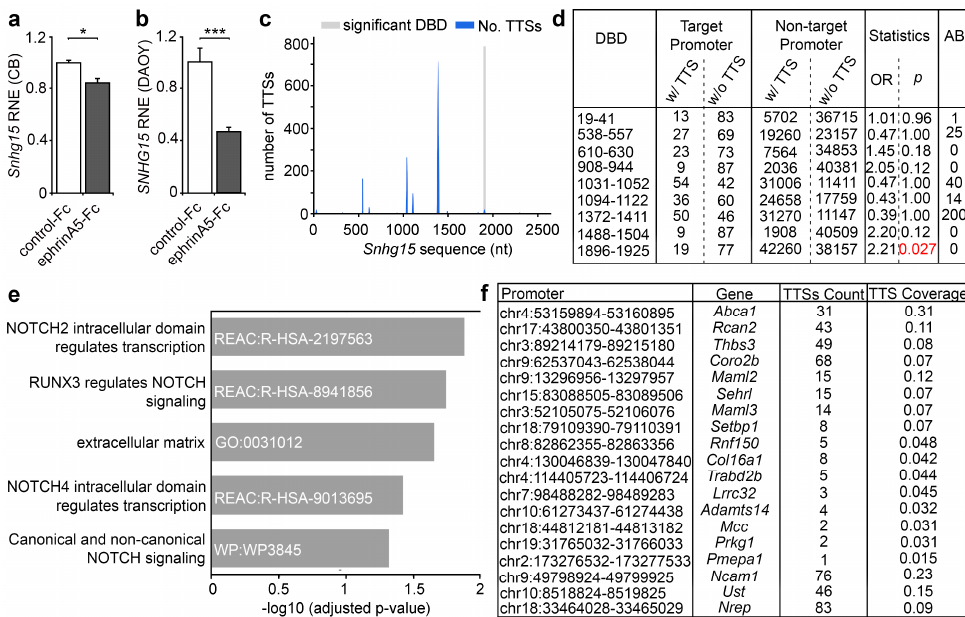
Figure 4. Analysis of Snhg15 expression and potential triplex target DNA sites (TTS) of Snhg15 in genes found differentially expressed upon ephrinA5-Fc stimulation. ( a ) Relative normalized expression (RNE) of Snhg15 in CB cells after ephrinA5-Fc stimulation compared to control-Fc treated CB cells. Expression data and adjusted p -value obtained from RNA sequencing of nuclear enriched RNA of CB cells. Sequencing was performed as n = 3 biological replicates per condition. ( b ) Quan- titative real time PCR analysis of expression of SNHG15 in DAOY cells treated with control-Fc or ephrinA5-Fc. Data are depicted as relative normalized expression (RNE) of ∆∆ Ct calculation ( n = 12 per condition, N = 4 biological replicates). ( c , d ) One significant functional DBD (DNA-binding domain) was identified for Snhg15 , ranging from nucleotides (nt) 1896-1925 ( p = 0.0274). This site reveals significant predicted binding to the promoter regions of 19 genes that were found significantly up-regulated among ephrinA5-Fc stimulation in CB cells. ( e ) Functional profiling analysis of the 19 putative Snhg15 target genes (g.Profiler; https://biit.cs.ut.ee/gprofiler/gost) revealed significant enrichment of extracellular matrix and NOTCH signaling-related genes. ( f ) Table collecting the promoter regions and names of genes identified as putative triplex target DNA sites (TTS) of Snhg15. Two-tailed Student’s t -test, * p < 0.05, *** p <